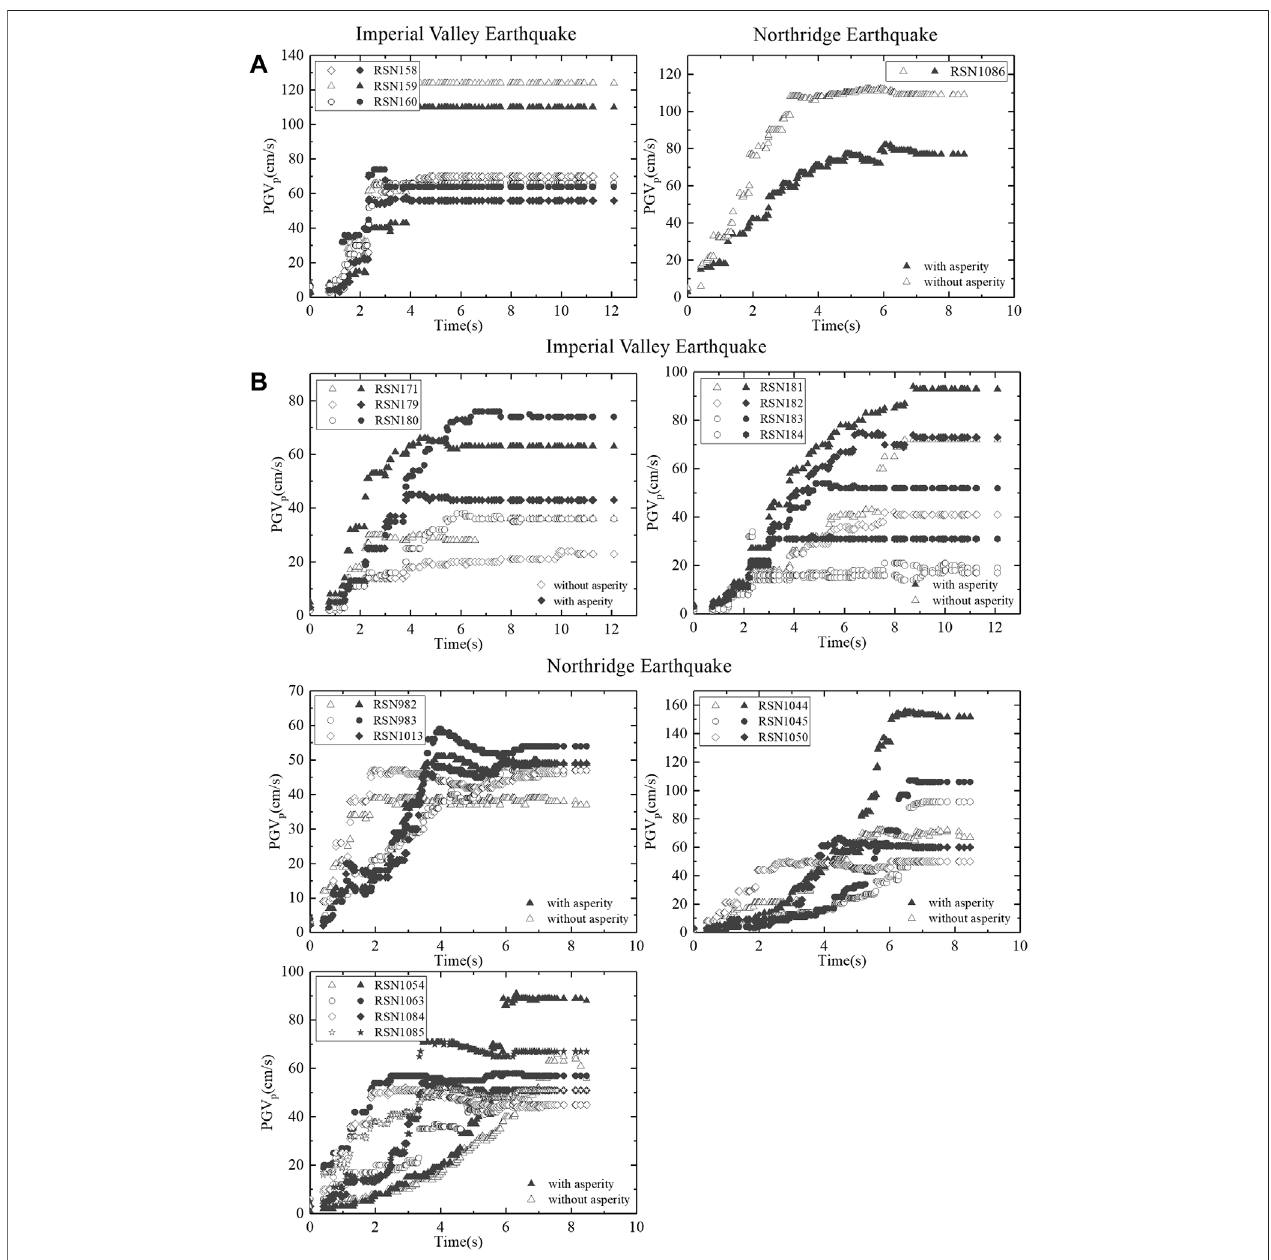
FIGURE 9 | PGV p values at (A) near-epicenter stations and (B) rupture-direction stations produced by homogenous and inhomogeneous slip distributions.